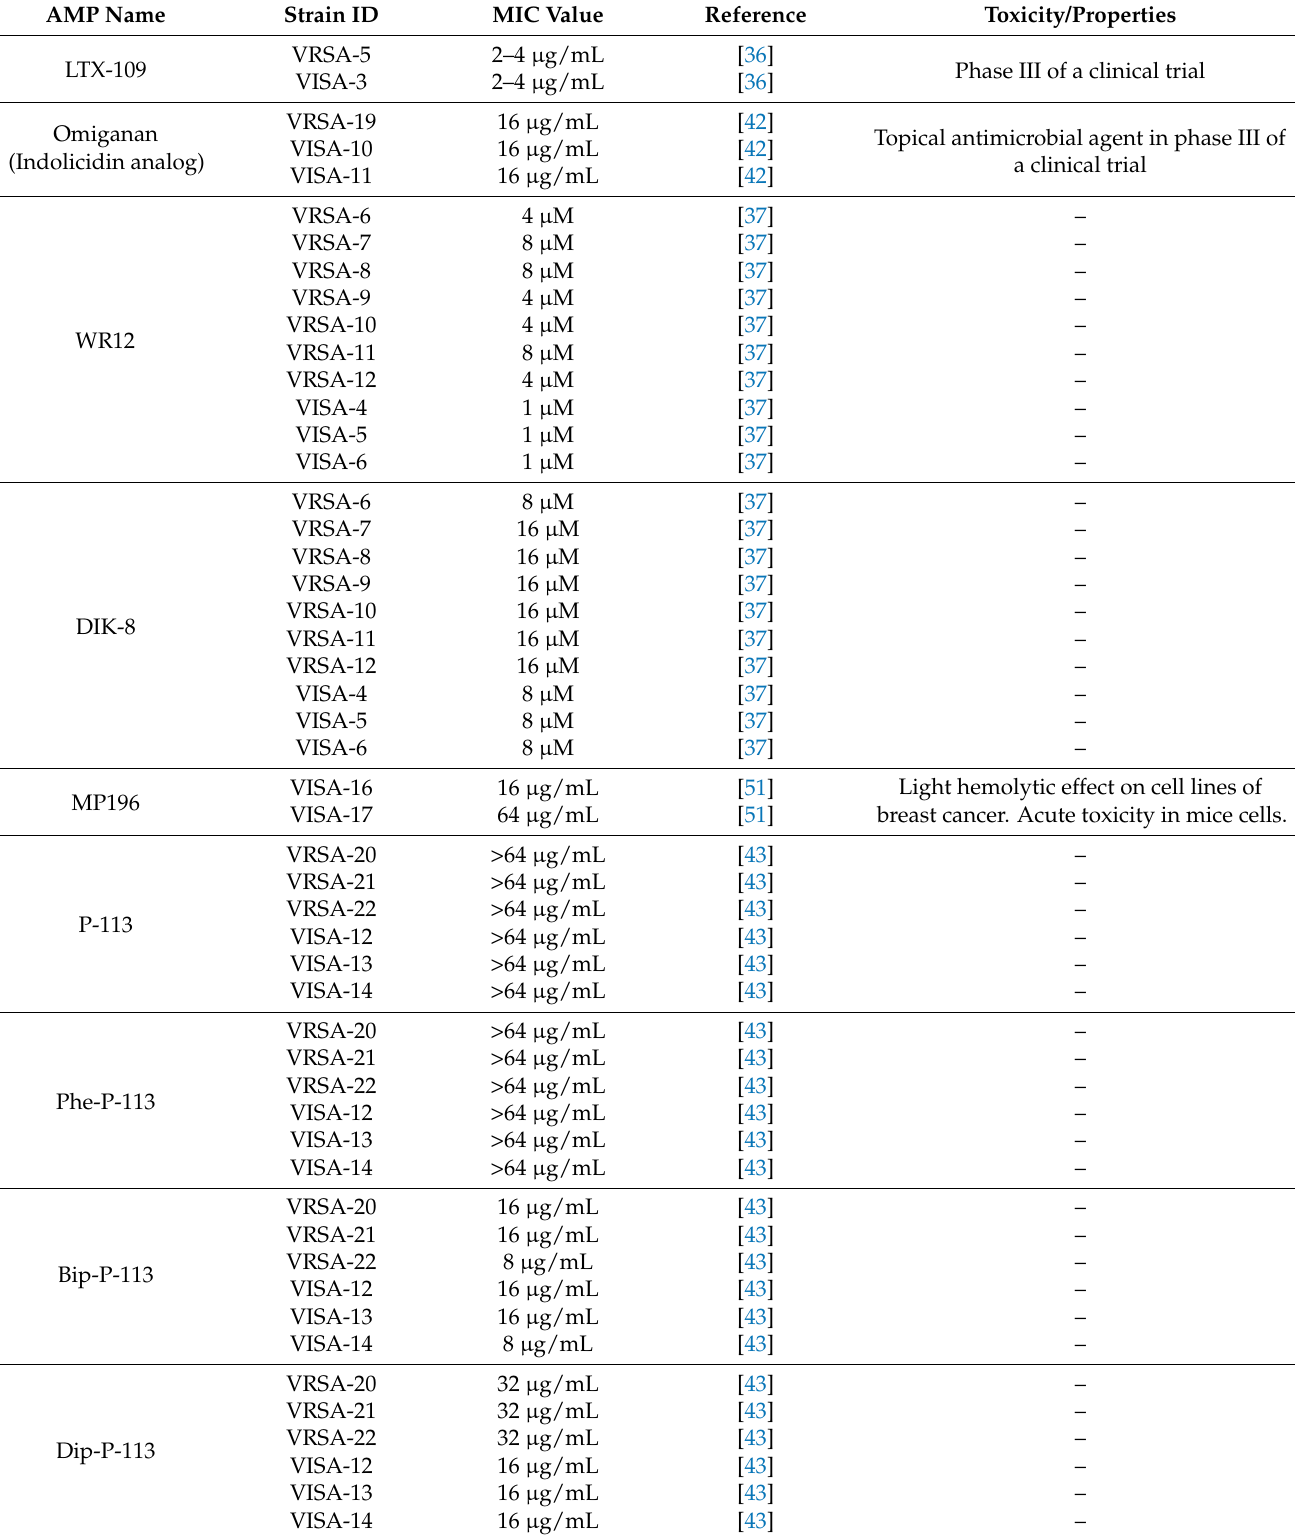
Table 4. Artificial AMPs with antibacterial activity against VRSA and VISA